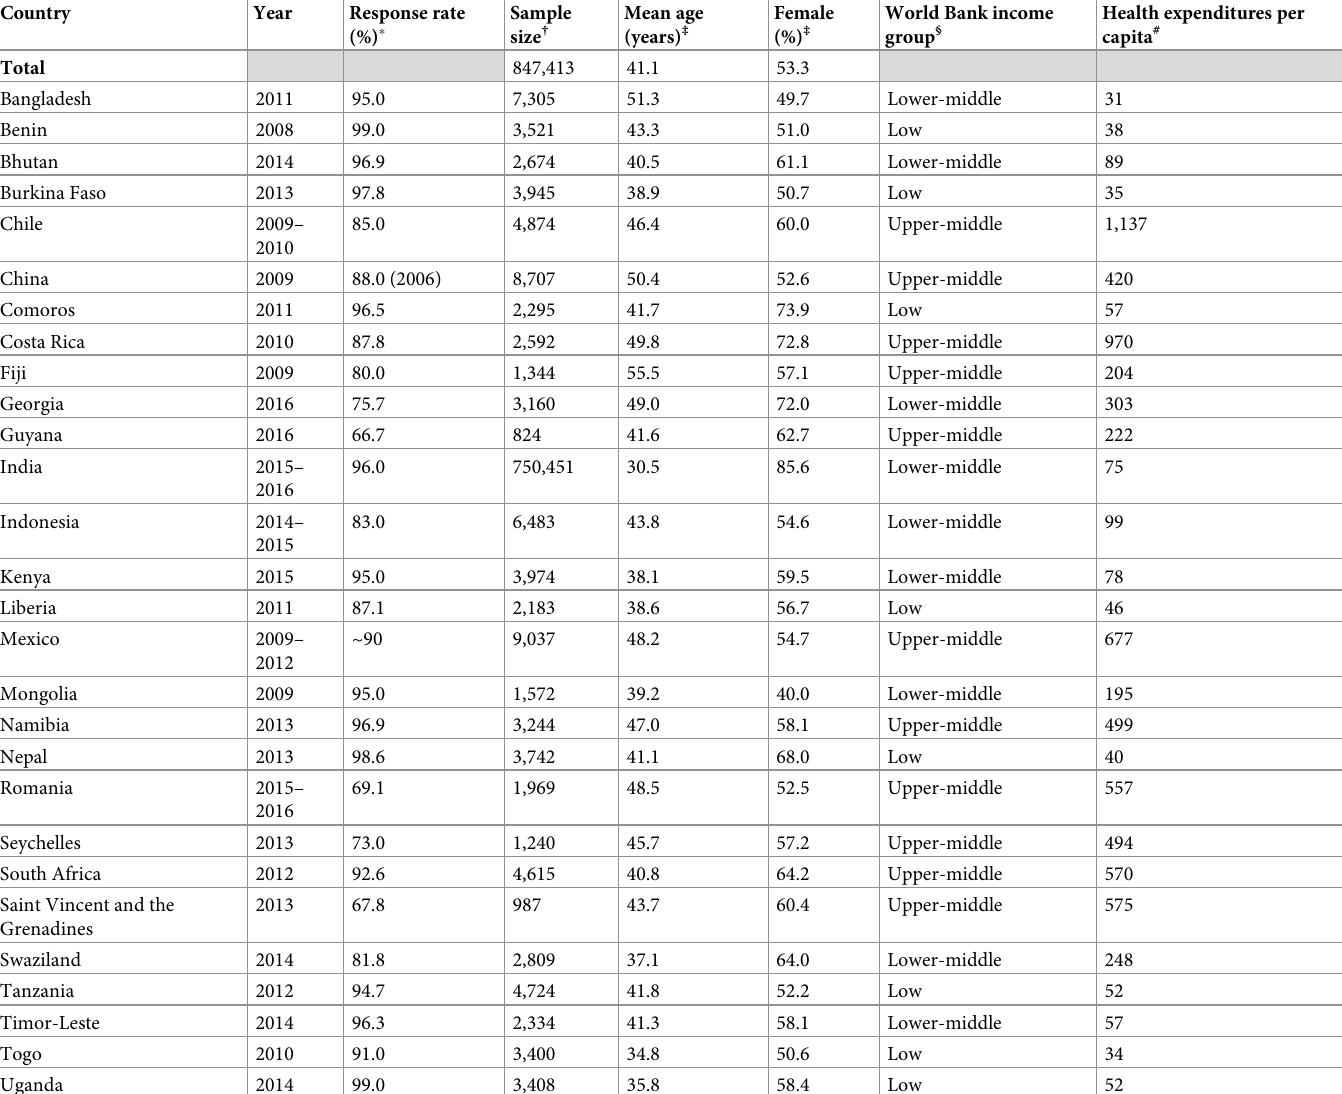
Table 1. Summary of population-based surveys conducted in 28 low- and middle-income countries between 2008 and 2016 and country-level characteristics.